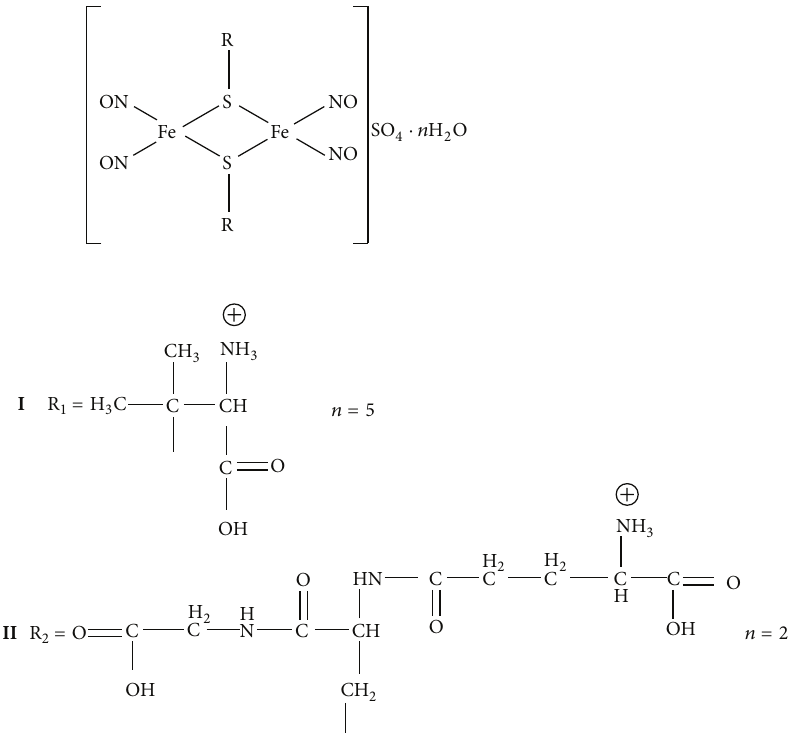
Figure 1: Chemical structures of the tetranitrosyl iron complexes ( I ) and ( II ) [14].